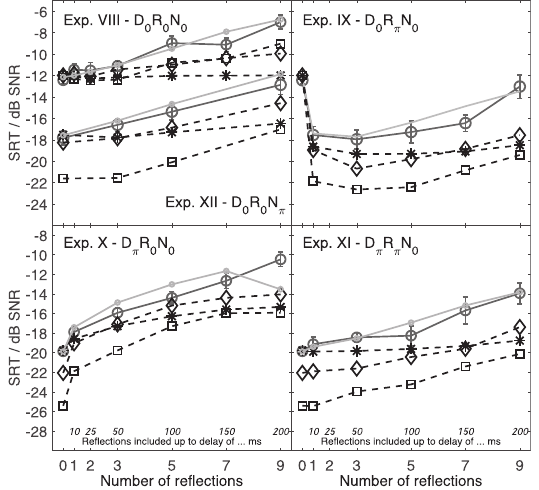
Figure 5. Measured and predicted SRTs for experiments VIII to XII displayed as in Figure 3. This fi gure shows the in fl uence of multiple re fl ections of the target speech, which were varied by increasing the number of speech re fl ection at different delays starting from early delays. IPDs were set as indicated. Note that the fi rst condition is always direct sound